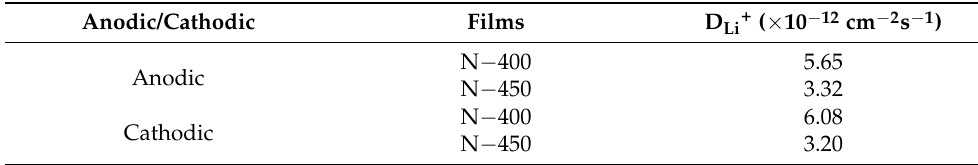
Table 1. Li + diffusion coefficients at different annealing temperatures.